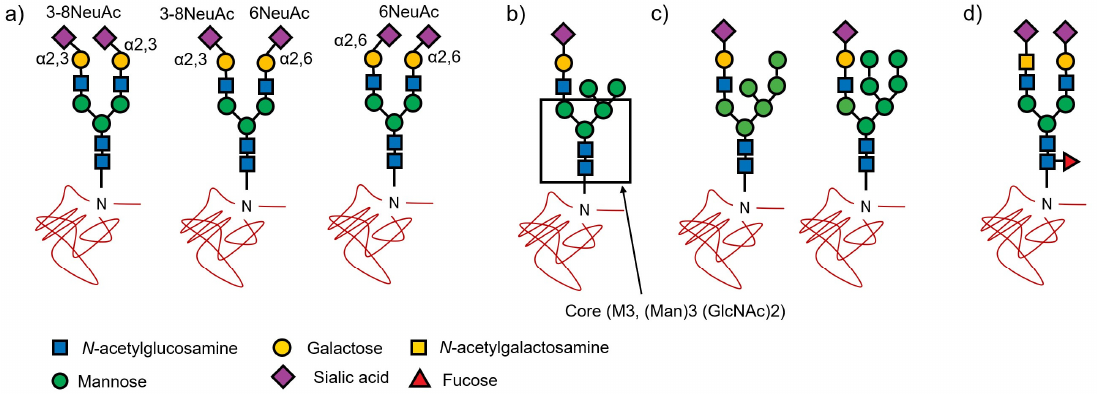
Figure 1. Structures of estimated mannose-rich hybrid glycans and LacDiNAc and a kind of structures of SALSA modification. ( a ) biantennary sialyl glycan (A2). ( b ) One commonly observed hybrid structure. ( c ) Estimated mannose-rich hybrid. ( d ) A LacDiNAc